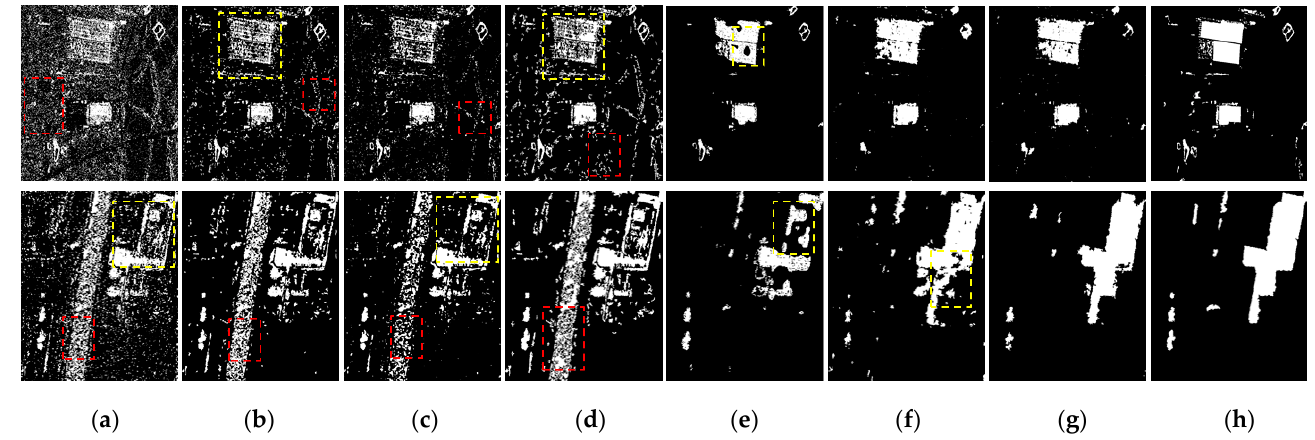
Figure 13. Change maps by different methods on the SAR data sets. ( a ) PCA-Kmeans. ( b ) ELM. ( c ) S-PCA-Net. ( d ) CWNN. ( e ) CNN. ( f ) MSGCN. ( g ) DNHGNN. ( h ) Reference change map.